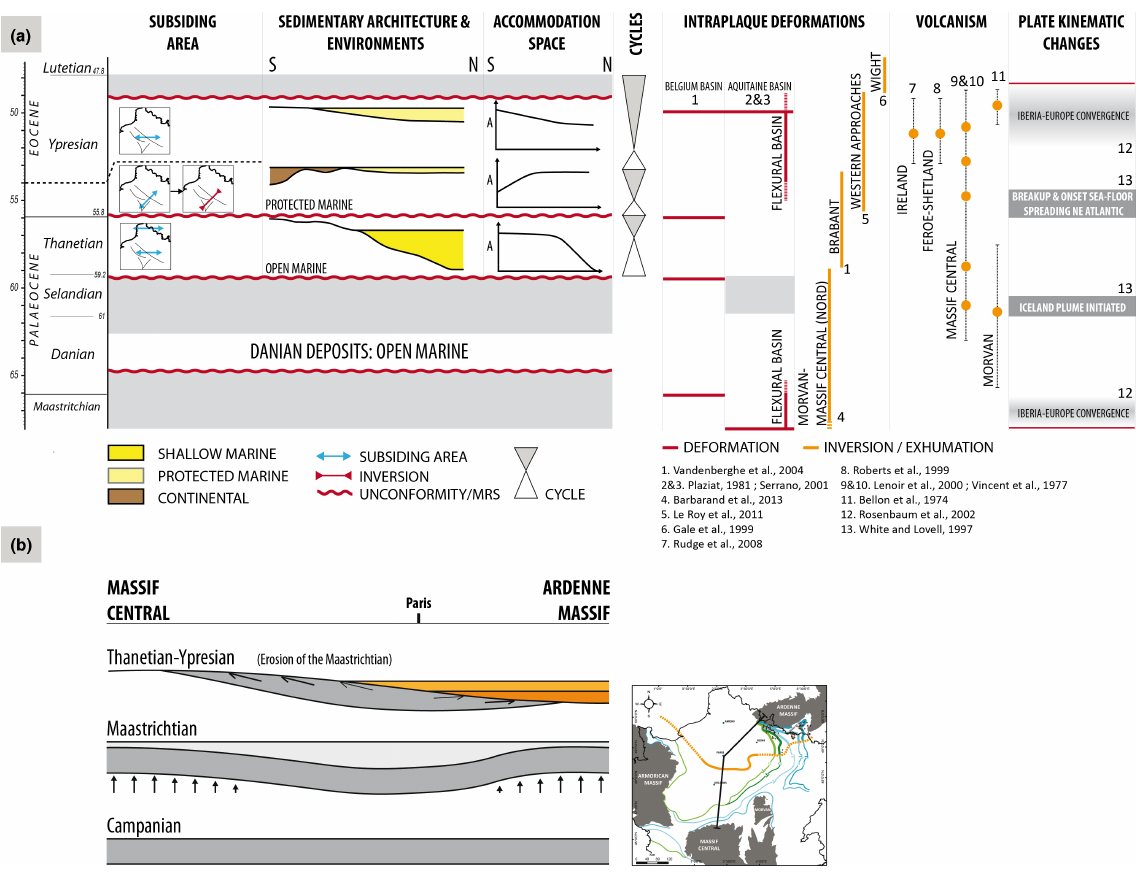
Figure 10. Evolution of the deformation of the Paris Basin during Palaeocene–Lower Eocene times – comparison with the surrounding domains: (a) Synthetic chart. (b) Deformation evolution along a N–S transect from the Ardennes Massif and the French Massif